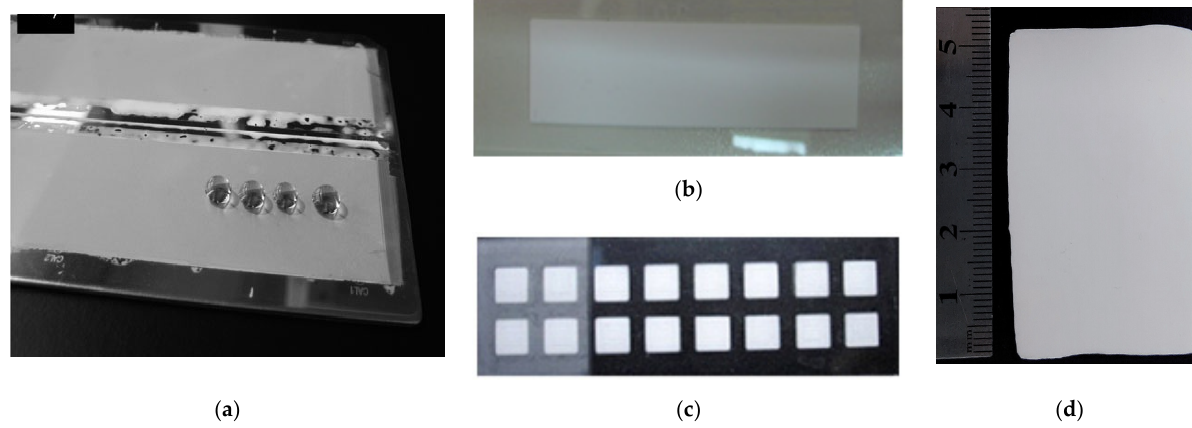
Figure 4. Images of thin monolithic layers prepared by different techniques: ( a – c ) traditional free radical polymerization of monomers in presence of porogenic solvents; ( d )—HIPE polymerization. In ( a , d ) polymerization was carried out on the glass surface using a mold constructed from two glass slides separated with Teflon strips. In ( b ) polymerization was done in a well prepared via etching with HF solution while in ( c ) the polymer areas were synthesized in the small wells manufactured on the glass surface by mechanical treatment with thin milling cutter. Design of layers ( a , b , d ) is suitable for both TLC and microarray while ( c ) for microarray only. Image ( a ) reprinted from [55] with permission of Jhon Wiley and Sons. Images ( b , c ) taken from the unpublished collection of the authors of this review. Image ( d ) reprinted from [48] (RSC Open Access).